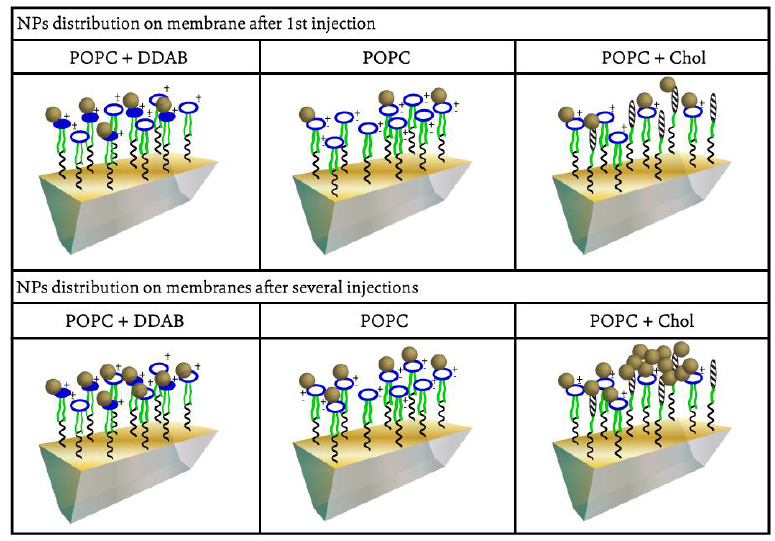
Figure 5. Schematic representation of the gold NPs adsorption on lipid membranes of different compositions under successive injections on SPRi biochip. Gold NPs (golden spheres) are homogeneously adsorbed on POPOC (white/blue dots) and POPC/DDAB (blue dots) membranes. The preferential binding to the region with cholesterol (hatched dots) promote gold NPs aggregation after several injections on the biochip.